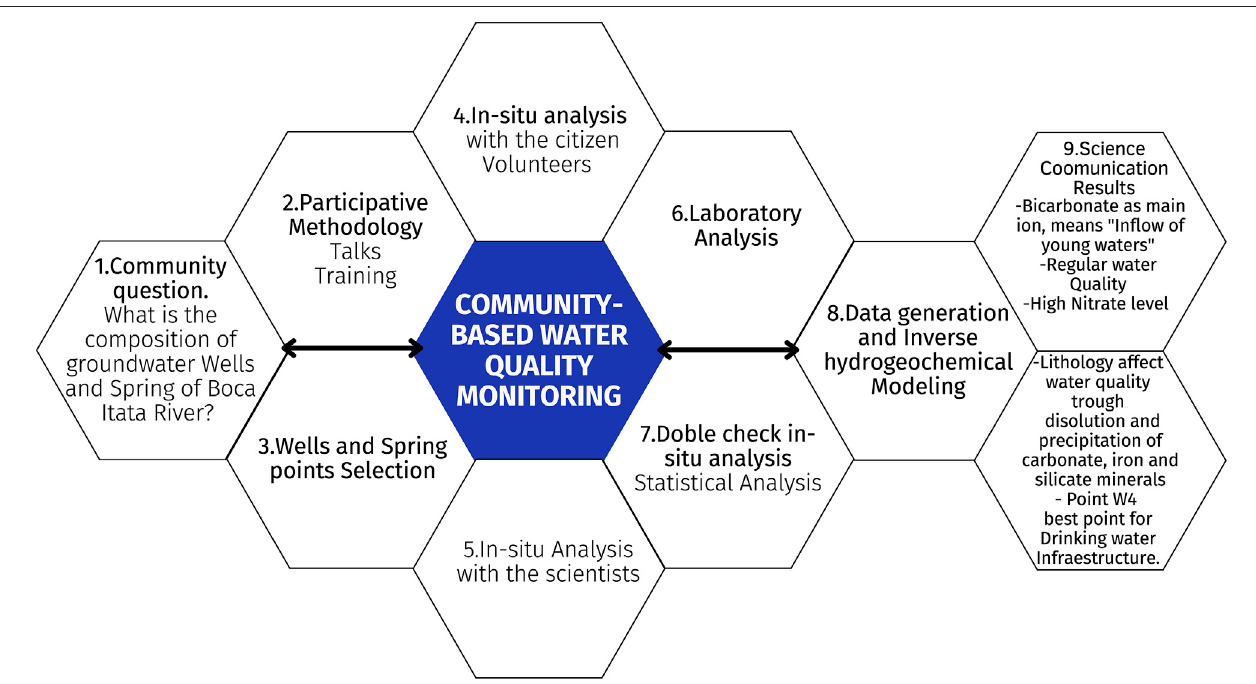
FIGURE 4 | Integrative scheme about main outcomes from the community-based water